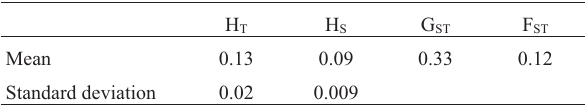
Table 3 - Mean and standard deviation of the genetic parameters of the Fusarium oxysporum f. sp. phaseoli isolates. H T H S